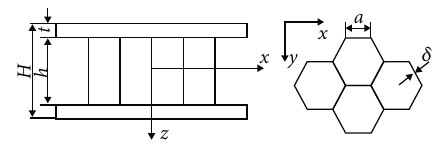
Figure 1: Cellular structure sketch. Table 1: The size and speci fi cation of the sample.